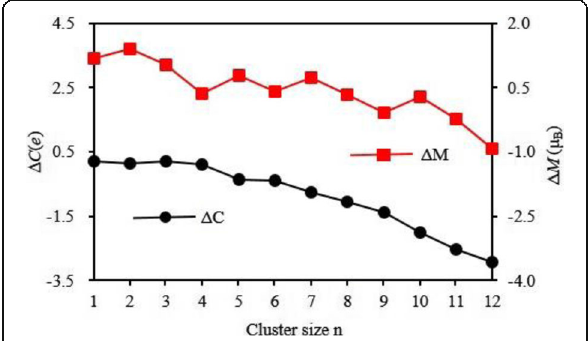
Fig. 10 The charge transfer ( Δ C) and the change of magnetic moment ( Δ M) of V atom in the most stable Ag n V ( n = 1 – 12)